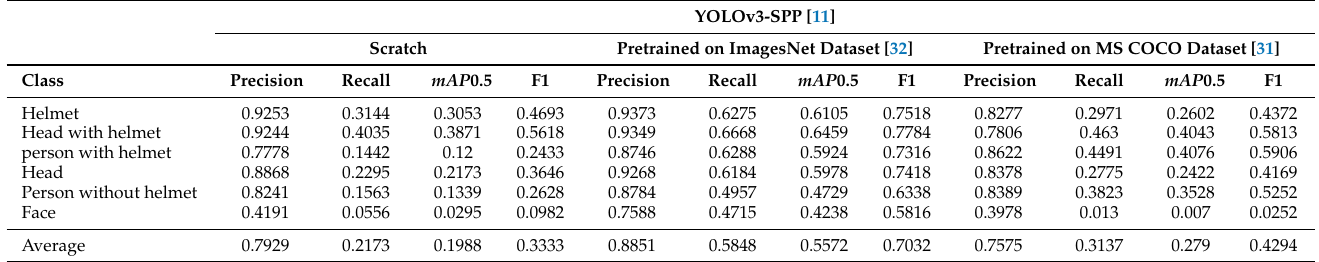
Figure 7. The YOLOv5x [13] detected outputs are plotted with the original images. Table 3. Comparison results of different variations of the YOLOv3 models (a) trained from scratch, (b) pretrained on the ImageNet dataset [32], and (c) pretrained on the MS COCO dataset [31].